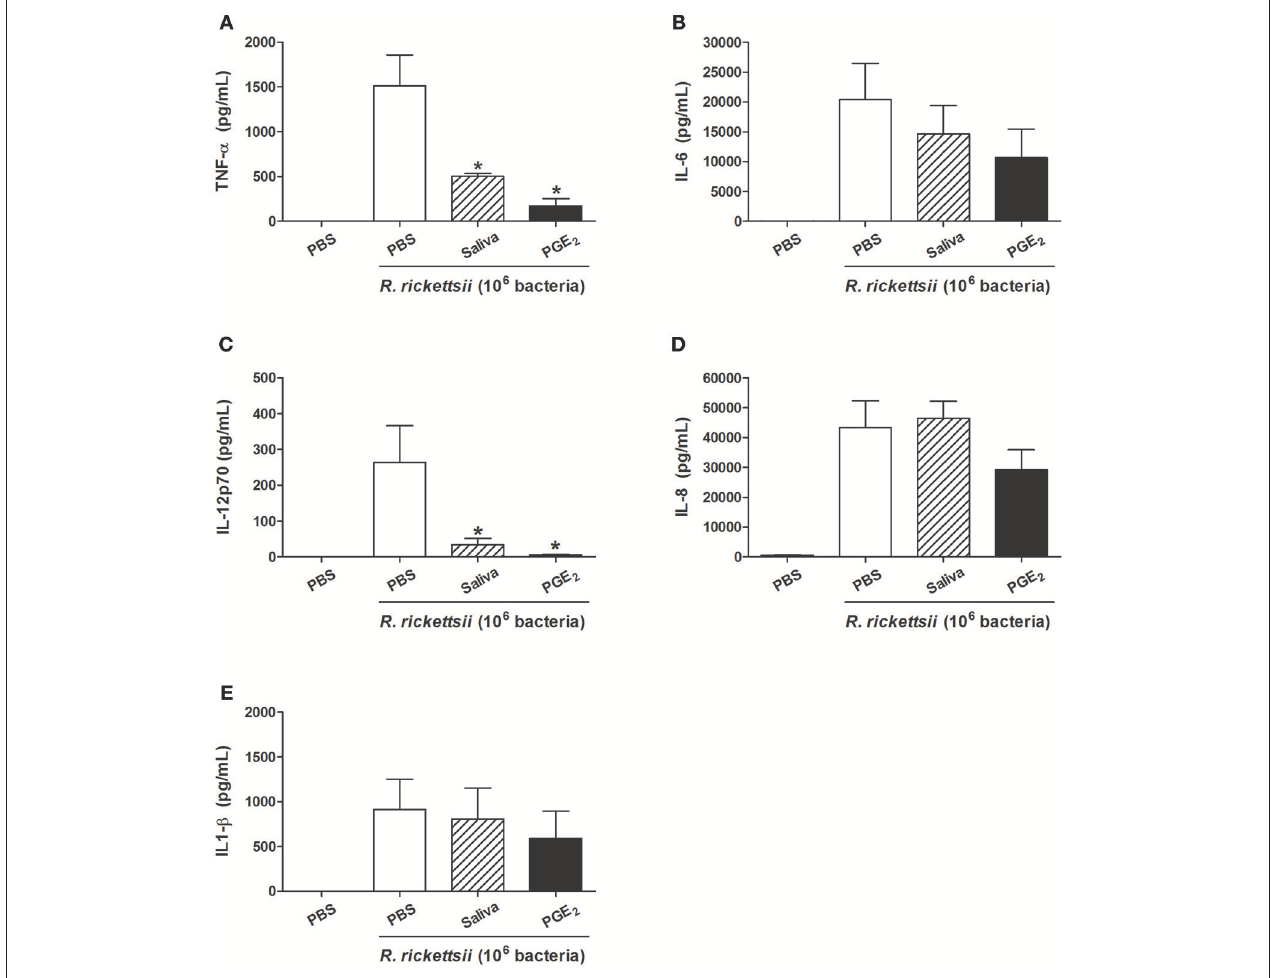
FIGURE 5 | A. sculptum saliva and PGE 2 downmodulate inflammatory cytokines produced by human DCs incubated with R. rickettsii . PBMC were differentiated into DCs, seeded at 10 5 cells/well in 96-well plates and preincubated for 1h with medium only, with A. sculptum saliva collected by dopamine stimulation from field female ticks (1:50 dilution) and PGE 2 (100nM). After that, cells were incubated with R. rickettsii (10 6 bacteria) during 24h for TNF- α (A) , IL-6 (B) , IL-12p70 (C) , IL-8 (D) , and IL1- β (E) determination in culture supernatants by CBA. Results are expressed as the mean ± SEM. * p ≤ 0.05 vs. “DC + R. rickettsii /PBS”